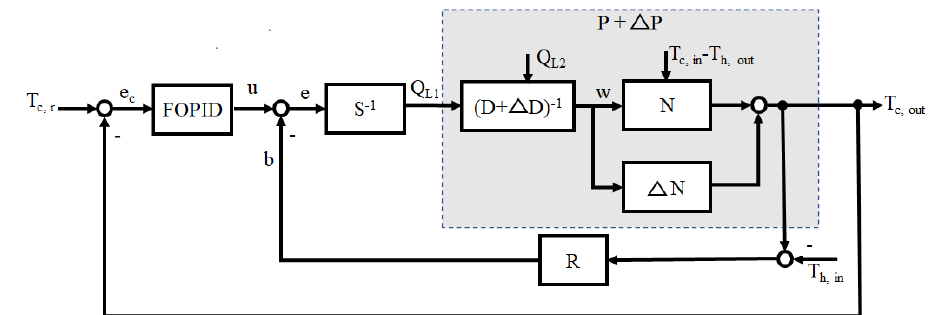
Figure 7. Operator-based fractional order robust control with FOPID.